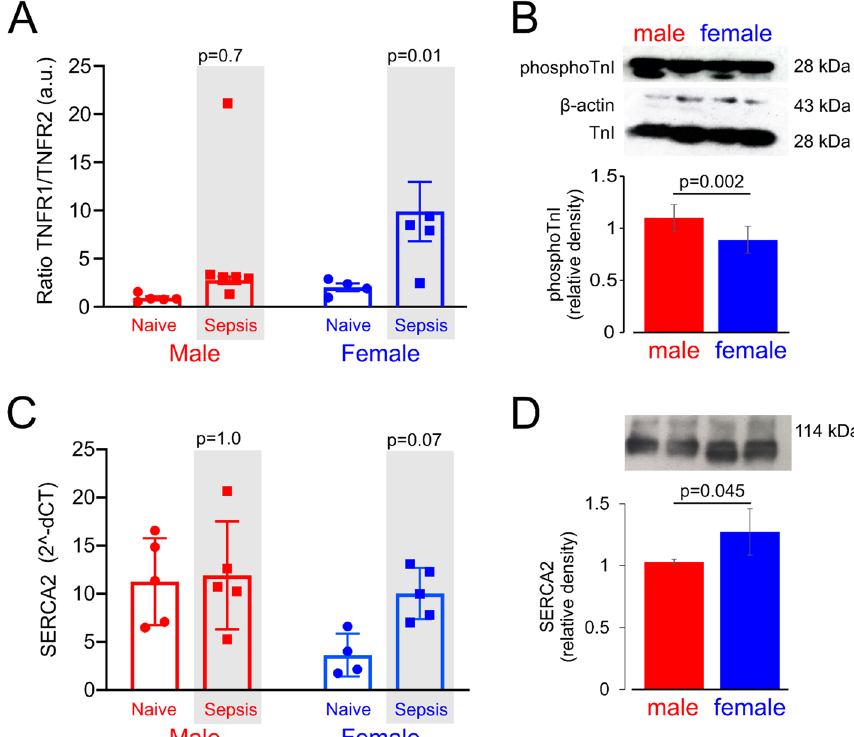
Fig. 6 Expression of genes regulating cardioprotection and contractility after polymicrobial sepsis. A TNFR1/ R2 ratio of mRNA expression in female and male wild-type mice before and 18 h after onset of sepsis ( n sex). B Immunoblot for phosphotroponin I protein expression in left ventricle 18 h after sepsis in wild-type male and female mice (uncropped version in Additional file 1). Β -actin corrected values are compared in summary graph for 8/mice each sex. Individual p values on each panel refer to post hoc testing after ANOVA testing for sex x gene interaction. C mRNA expression of sarco(endo)plasmic reticulum Ca2 (SERCA2) female and male wild-type mice before and 18 h after onset of sepsis ( n on each panel refer to post hoc testing after ANOVA testing for sex x condition interaction. D Immunoblot for SERCA2 protein expression in left ventricle 18 h after sepsis in wild-type male and female mice (original uncropped version in Additional file 1). Β -actin corrected values are compared in summary graph for 8/ mice each sex. Individual p values on each panel refer to post hoc testing after ANOVA testing for sex x gene